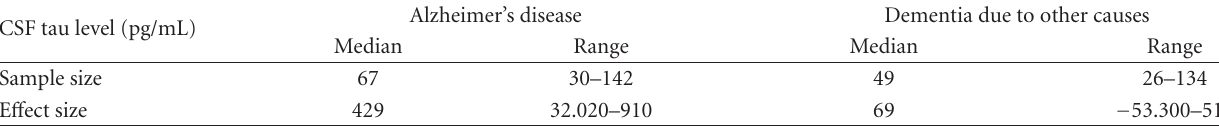
Table 2: Descriptive statistics of CSF tau studies in Alzheimer’s disease and dementia due to other causes.